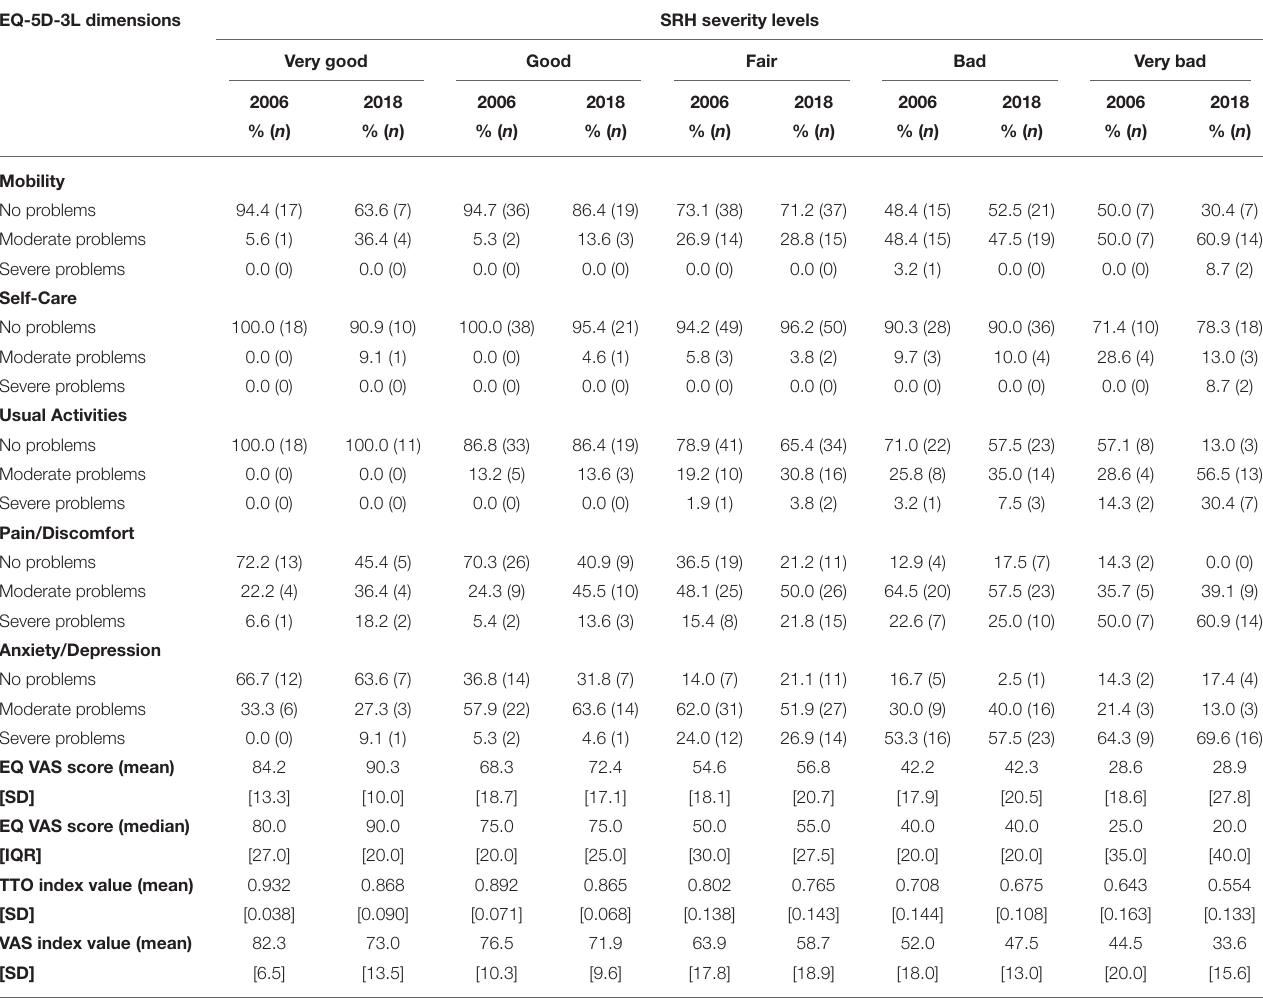
TABLE 4 | Problems in EQ-5D-3L dimensions (%, n ), mean and median EQ VAS score, mean TTO index value, mean VAS index value, by self-rated health (SRH) severity level, homeless people in 2006 and 2018, Stockholm. EQ-5D-3L